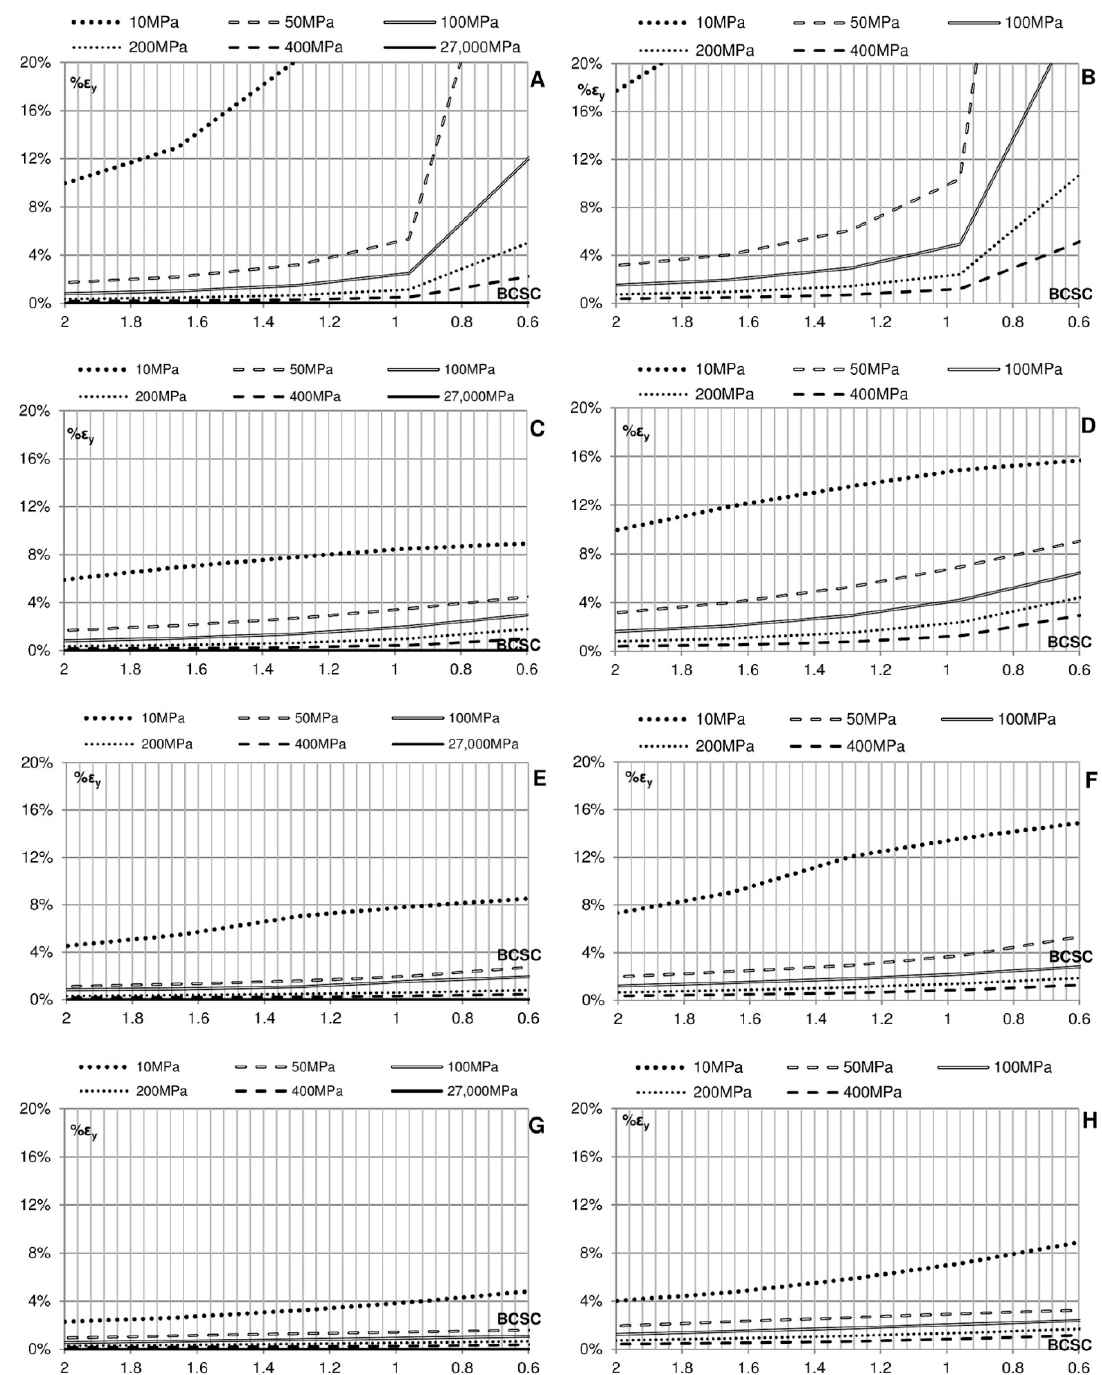
Figure 23. Soil deformation as a function of Bearing Capacity Safety Coefficient (BCSC) and Young’s modulus. Permanent: ( A ) elastic soil; ( B ) elasto-plastic soil. Sinusoidal: ( C ) elastic soil; ( D ) elasto-plastic soil. Impulsive 1: ( E ) elastic soil; ( F ) elasto-plastic soil. Impulsive 2: ( G ) elastic soil; ( H ) elasto-plastic soil.